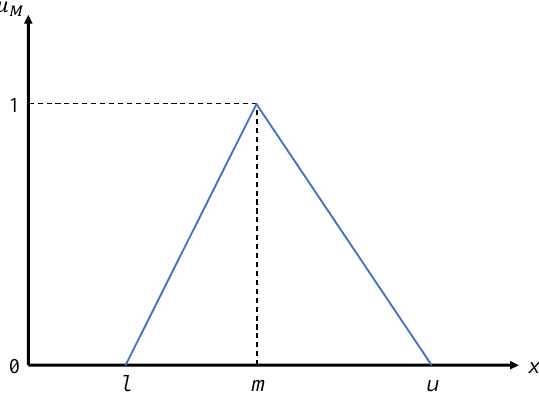
Figure 2. The membership function of triangular fuzzy number